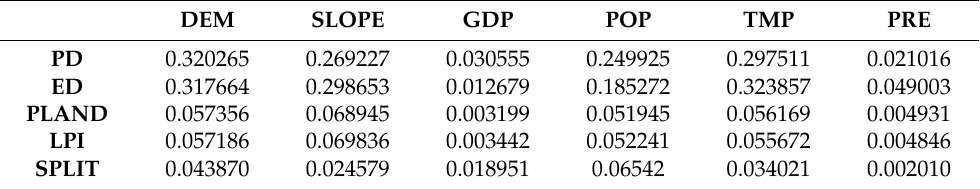
Table A1. The force (q-value) among each influencing factor on each landscape pattern metric in 1990.